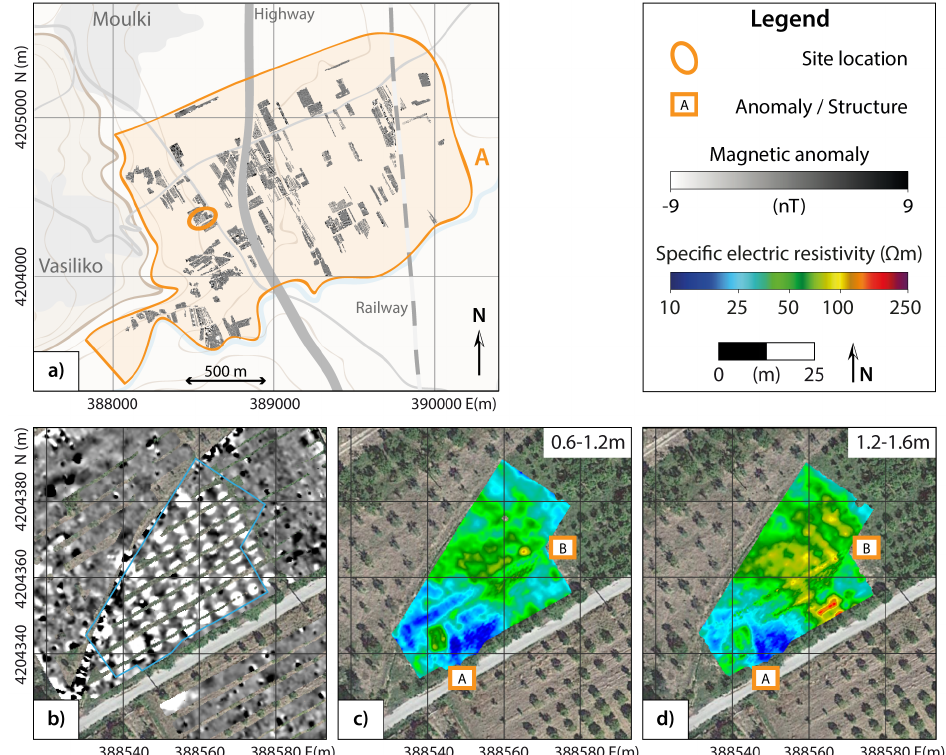
Figure 8. Case 4: Sikyon–Ayios Nikolaos. ( a ) Sketch of survey area A (compare Figure 1c) with magnetic map and the marked site location. ( b ) Results of the magnetic prospection. The blue box shows the electrical resistivity tomography (ERT) survey area shown in the neighboring panels (cf. Figure 3). ( c ) 0.6–1.2 m depthslice of the ERT survey. ( d ) 1.2–1.6 m depthslice of the ERT survey. Source of satellite images ( b – d ): Google